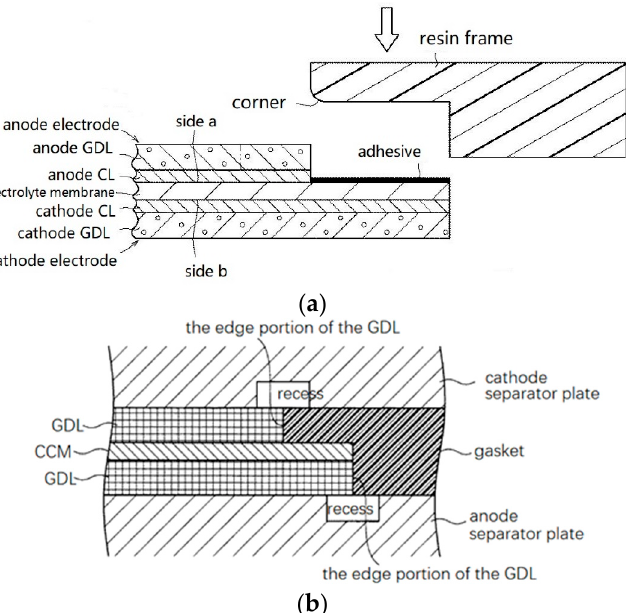
Figure 10. Measures to relieve shear stress. ( a ) stepwise MEA and resin frame [91]; ( b ) recesses formed on the cathode and anode separators [96].